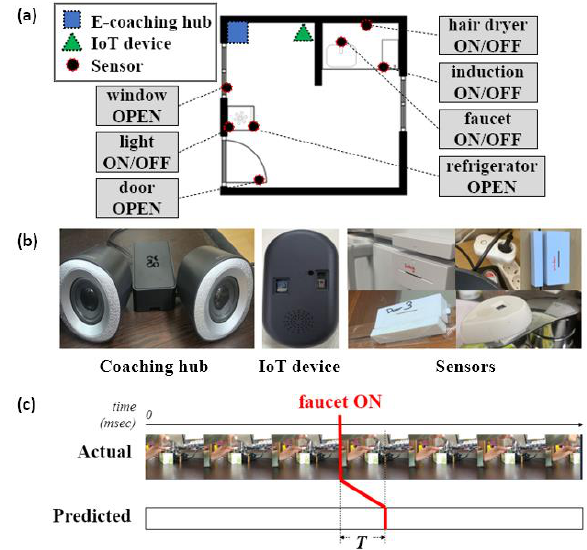
Figure 14. ( a ) Test environment for the progression of an ADL evaluation scenario. ( b ) E-coaching hub, IoT device, and sensors constituting the test environment. ( c ) Measurement of the time gap T between the actual and predicted behaviors by the system.